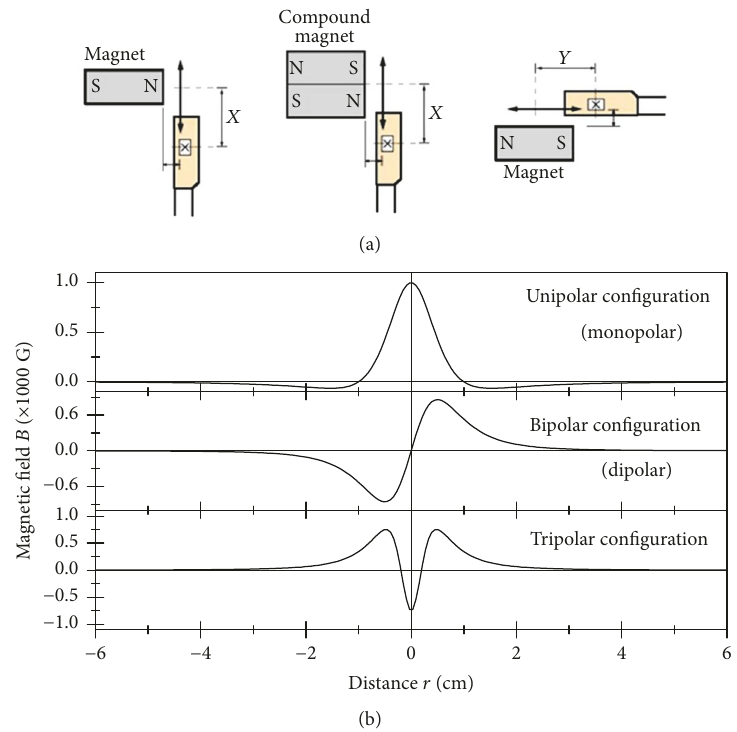
Figure 2: (a) The diagram of the measurements using the Hall sensor for the magnetic field of the compound magnets, in order to carry out a comparison with the light patterns observed in the Ferrocell. In (b), there are plots of the magnetic fields for different compound magnets. The coordinate 𝑟 represents a generic coordinate, which can be replaced by 𝑥 and 𝑦 , or it represents the polar coordinate, depending on the magnetic field